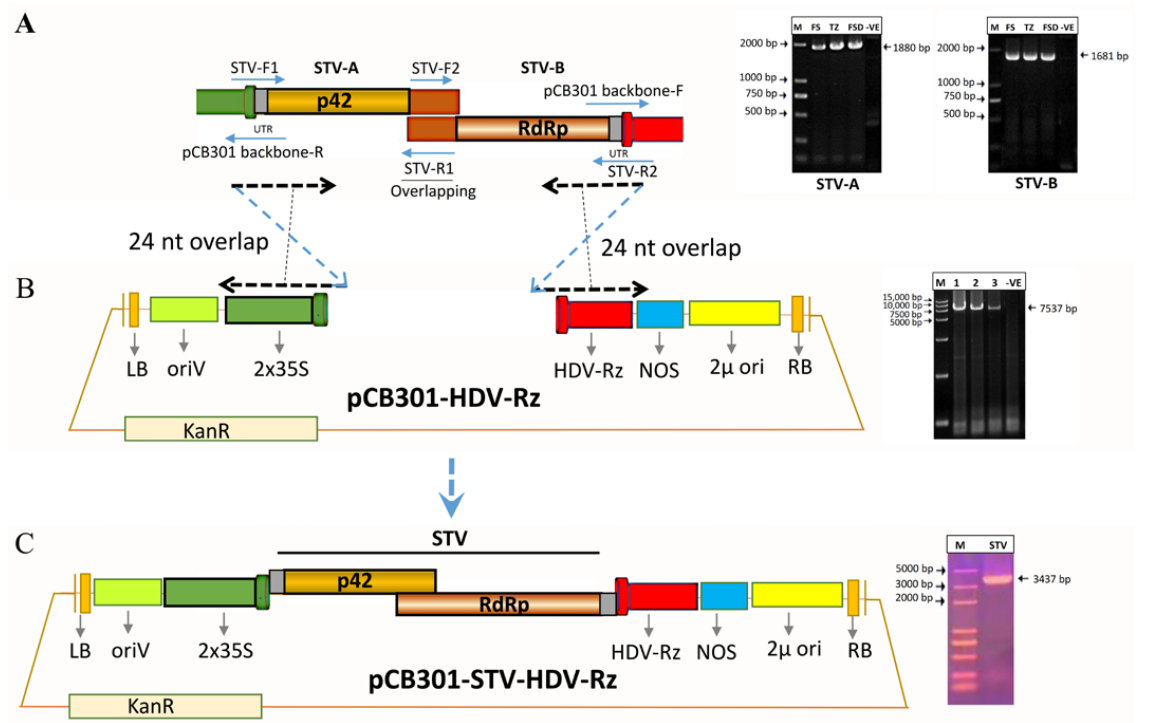
Figure 3. The schematic representation of the STV full-length genome and molecular cloning. ( A ) The STV full-length genome was amplified into two parts with overlapping pairs of primers (overlapping 24 nt from the 3′ - and 5′ -UTR of STV to the vector plasmid pCB301-2μ-HDV) with high-fidelity PCR. ( B ) The pCB301-HDV-Rz was linearized between the CaMV 35S promoter and the HDRz sequence using high-fidelity PCR. ( C ) Amplified STV parts A and B were assembled via yeast homologous recombination cloning and the full-length genome was constructed.